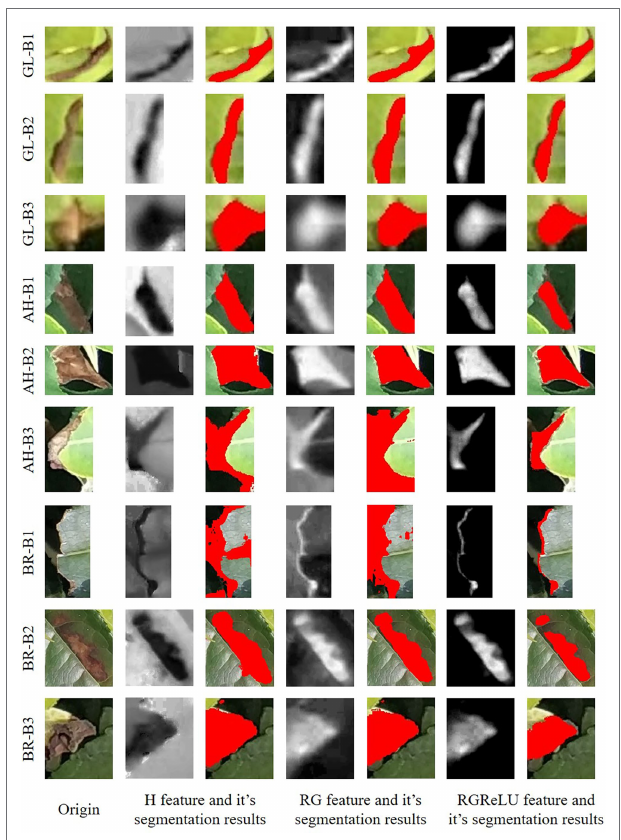
FIGURE 10 | The segmentation results of tea plant stress by using different features. GL-B, AH-B, and BR-B denote the detection box images of tea green leafhopper, anthracnose, and sunburn,